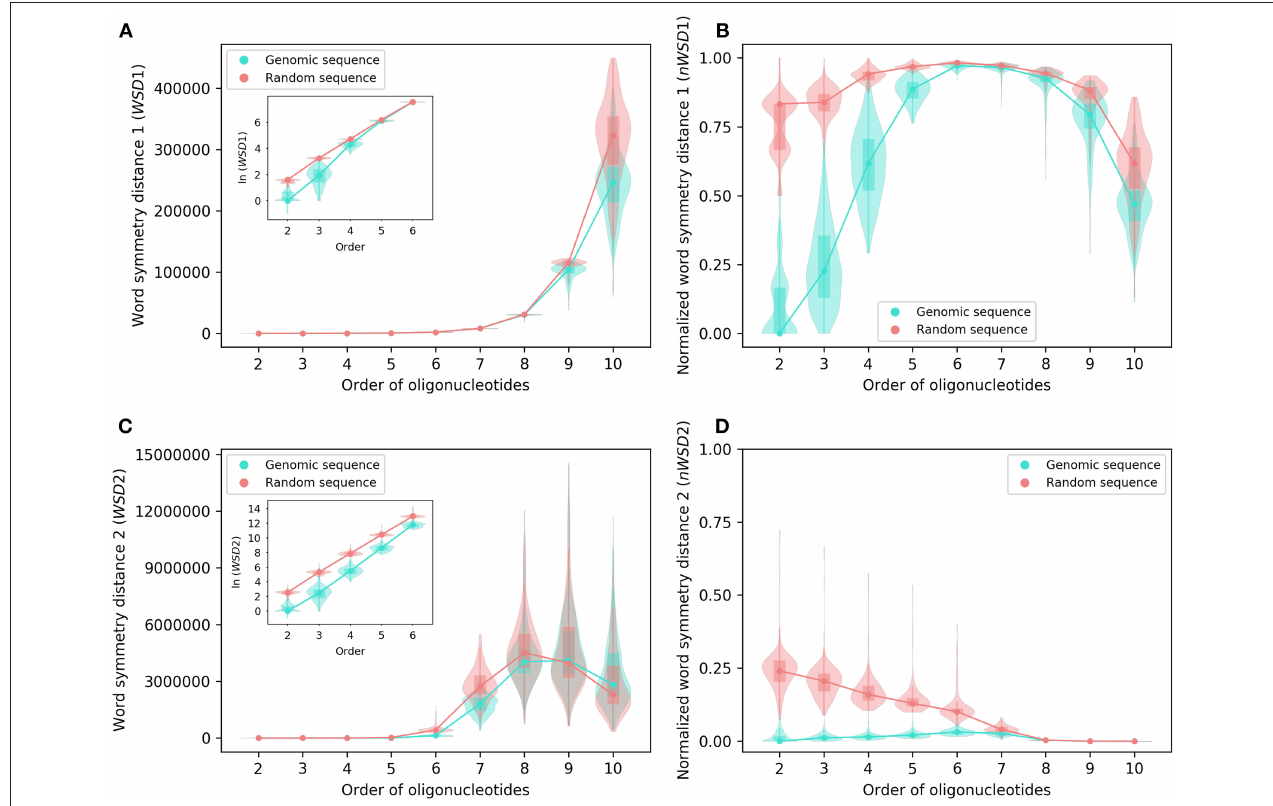
FIGURE 2 | Various word symmetry distances for 206 archaeal genomes and their corresponding random sequences. (A) WSD 1. (B) nWSD 1. (C) WSD 2. (D) nWSD 2. The values of WSD are presented in natural logarithm in insets (A,C) . For other explanations see the legend of Figure 1